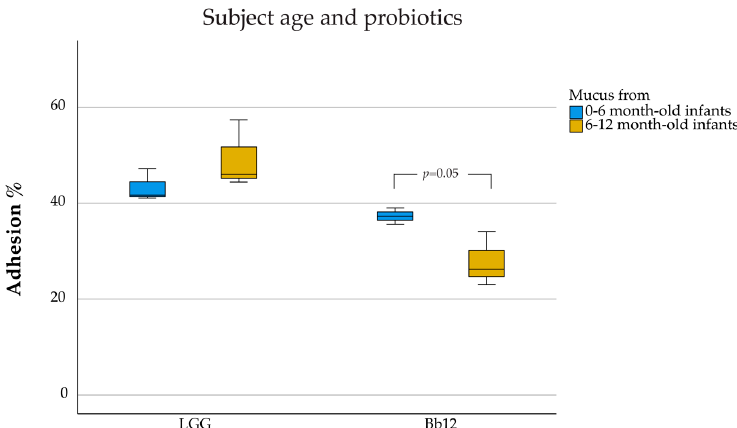
Figure 2. Adhesion of L. rhamnosus GG and B. lactis Bb12 as affected by age of mucus donor. Box-plot graphs represent the median and quartiles of adhesion (%) for the three independent experiments in triplicate. Outliers are marked with a circle (o).